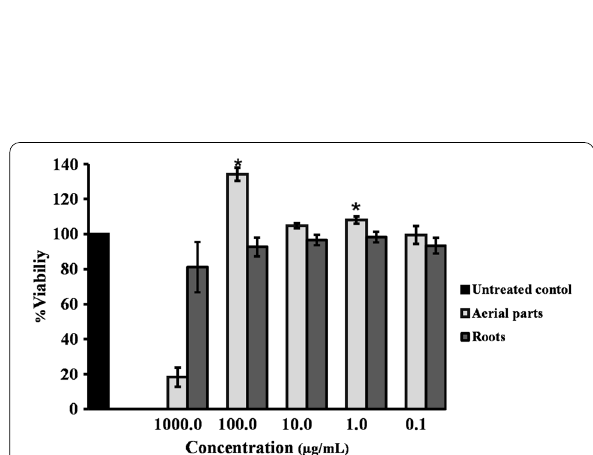
SEM ( n 9). Statistical ± =